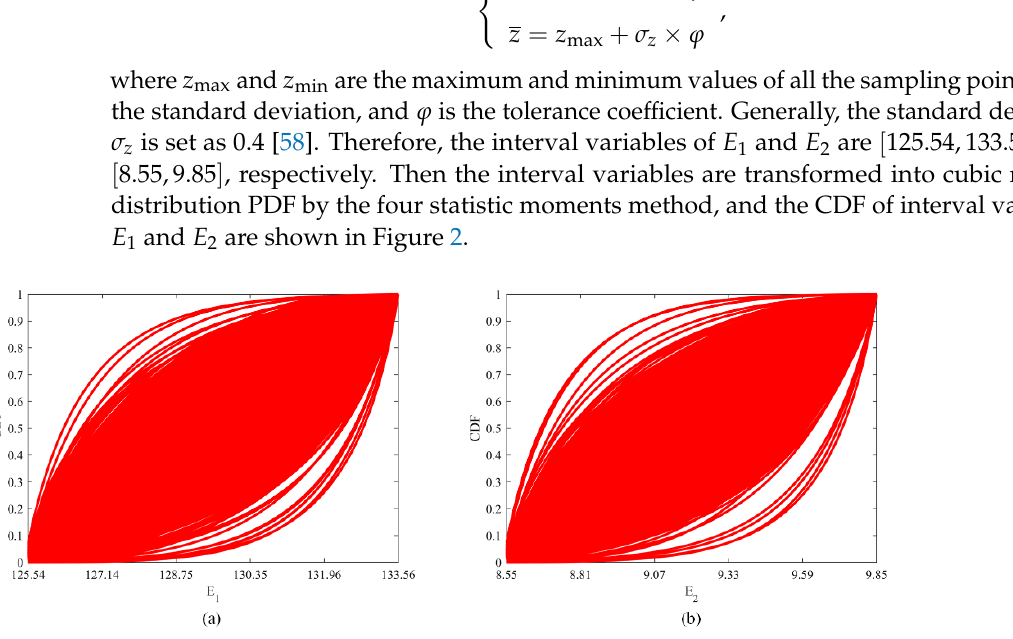
Figure 2. Cumulative probability density functions of interval variables ( a )